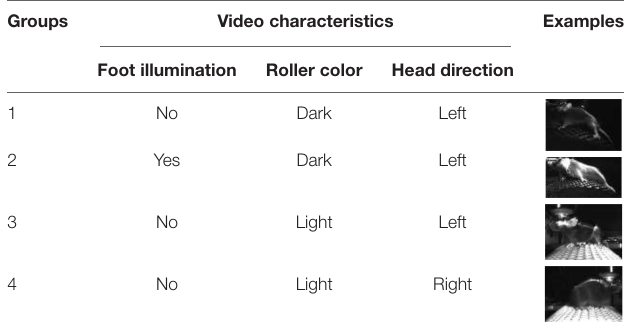
TABLE 1 | Groups of the mouse freely running dataset. Groups Video characteristics